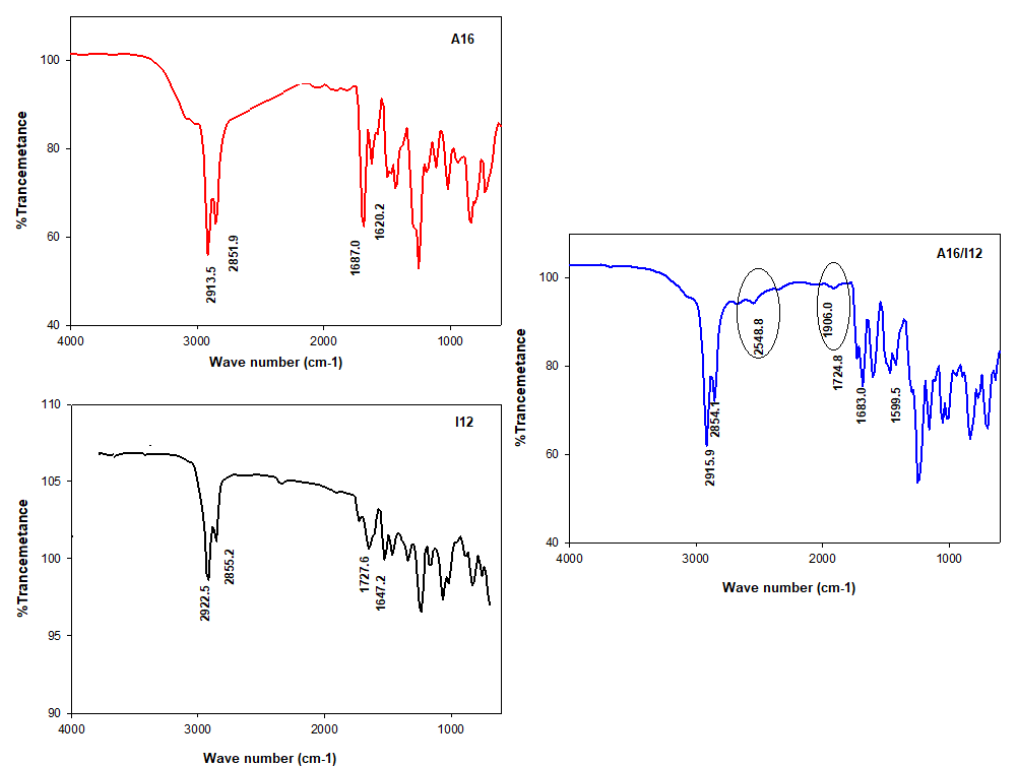
Figure 1. FT-IR spectrum of the acid A16 , I12 and their Supramolecular H-bonded Complexes (SMHBCs) A16 / I12 .